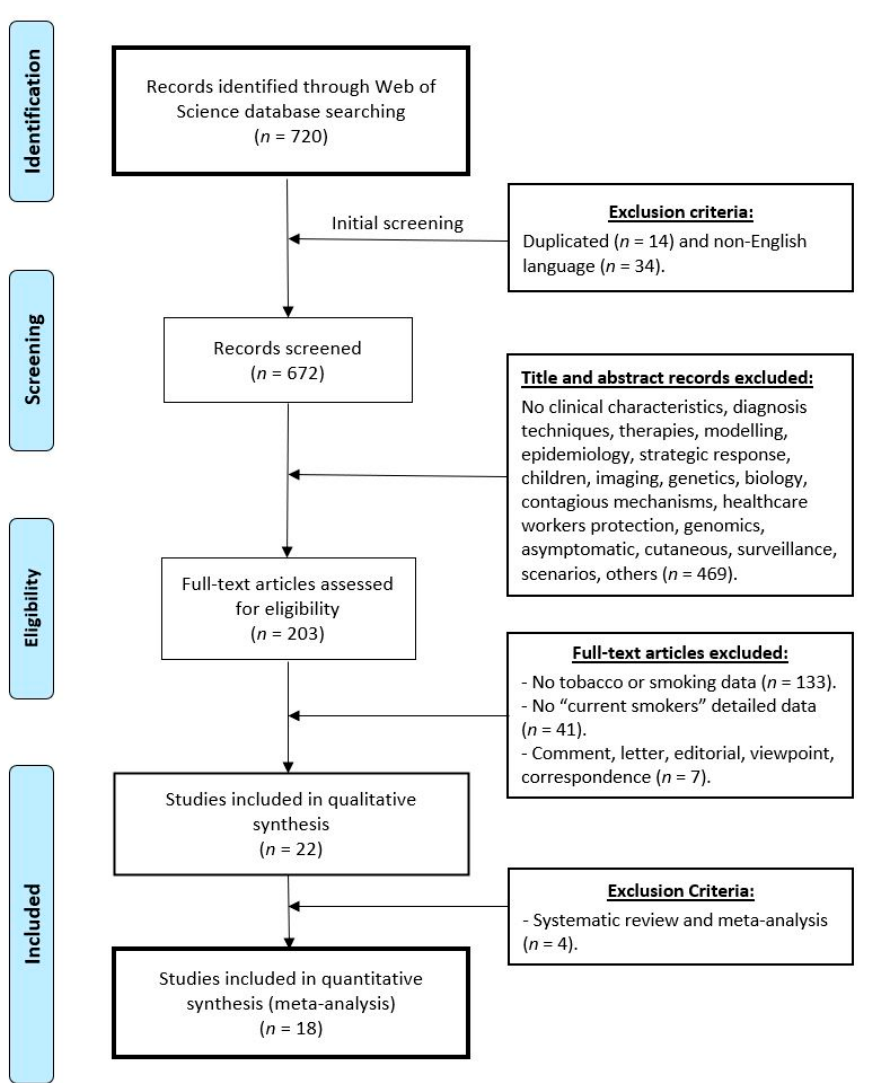
Figure 1. Flow chart diagram visualising the database searches, number of publications identified, screened, and final full texts included in the present systematic review and meta-analysis. Exclusion criteria are indicated.